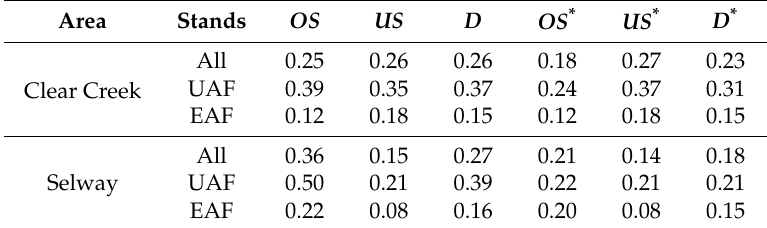
Table 5. Area-based dissimilarity metrics calculated from the validation dataset presented in Figure 10: Oversegmentation ( OS ), undersegmentation ( US ), summary score ( D ), modified oversegmentation ( OS ∗ ), modified undersegmentation ( US ∗ ), and summary score ( D ∗ ).